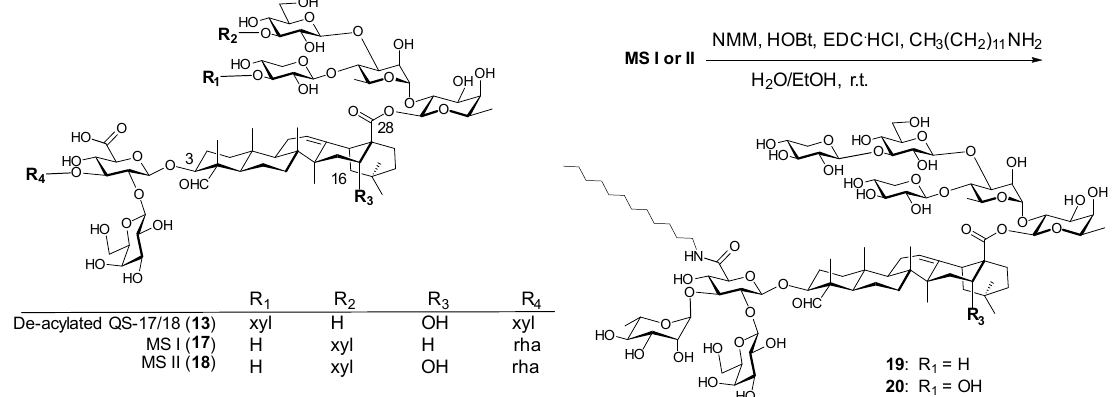
Figure 6. Structural similarity between Momordica saponins (MS) and de-acylated QS-17/18 and MS derivatization. Indeed, the new derivatives, 19 and 20 , showed significantly improved adjuvant activity in terms of antigen-specific IgG secretion when compared with the natural Momordica saponins (Figure 7). It was expected that the derivative of MS II should resemble the adjuvant property of 14 more than that of MS I in that both MS II and QS derivatives have the same quillaic acid triterpene core while MS I has a gypsogenin core. Interestingly, it was the derivative of MS I, i.e., 19 (named VSA-1), showed an IgG2a/IgG1 ratio similar to that of 14 and the positive control GPI-0100 (Figure 7). Wang et al. went on to confirm that in the MS series of derivatives, the structure of the incorporated side chain has a significant impact on adjuvanticity [119], as seen in the QS series of derivatives [95,116,119]. Among the studied MS derivatives, VSA-2 ( 21 , Figure 8), a derivative of MS II through incorporating11-aminoundecanoic acid benzyl ester as side chain, showed a consistently higher IgG2a/IgG1 ratio than that of GPI-0100 [119] and QS-21 (unpublished results). Interestingly, with this same side chain, the MS I and MS II derivatives demonstrated dramatically different adjuvant activities; the MS I derivative showed much lower IgG2a titers than both 19 (VSA-1) and 21 (VSA-2) with similar overall IgG titers. Again, these results suggest that a saponin’s adjuvant property is probably determined by its specific molecular structure (including the side chain structure), not by its overall amphipathicity, HLB, or the presence/absence of a particular functional group.